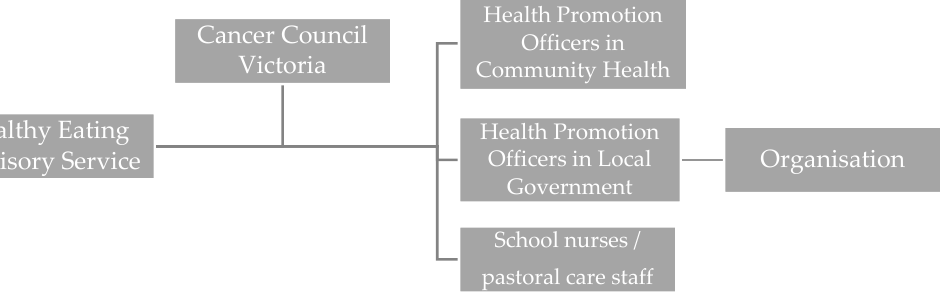
Figure 2. Streamlined support pathway to implement the Healthy Choices Guidelines and School Canteens and Other Food Services Policy determined from the analysis of the interviews.